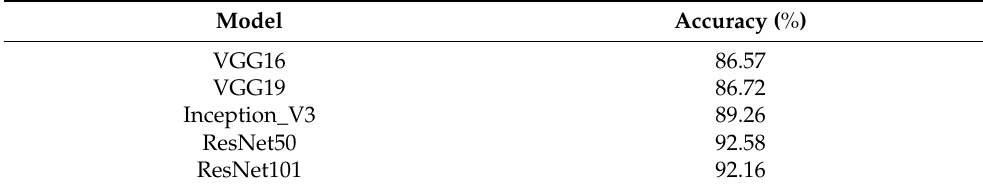
Table 3. Traditional classification networks.